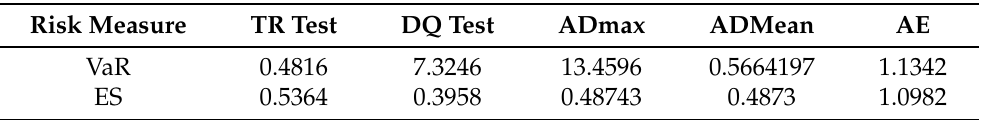
Table 8. Backtesting one-step ahead value-at-risk and wxpected shortfall at α = 1% risk level using tail risk and dynamic quantile tests. The TR tells how much loss a portfolio can incur while the DQ of the joint hypothesis is at α level of